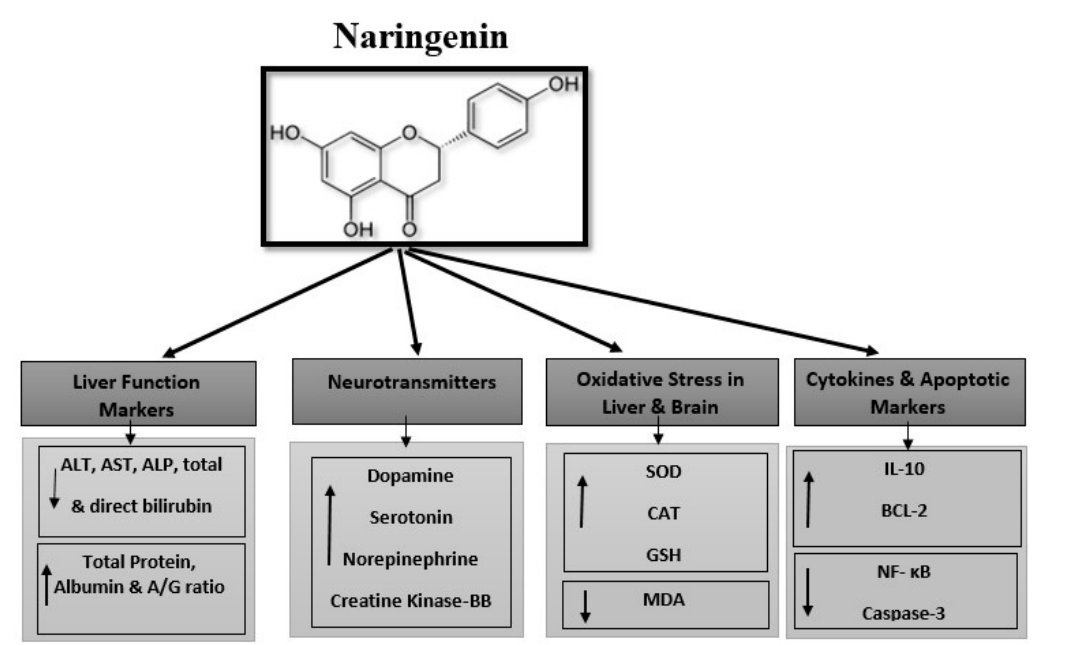
Figure 12. Hepato- and neuroprotective effects of naringenin against lead acetate toxicity. ↑ : mean increase the value and ↓ : mean decrease the value.